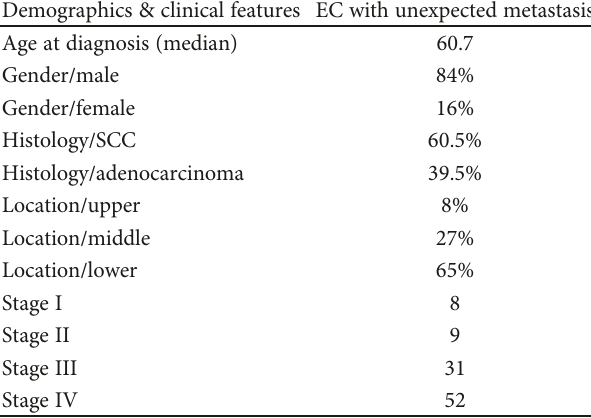
Table 1: Clinicopathological characteristics of EC with unexpected